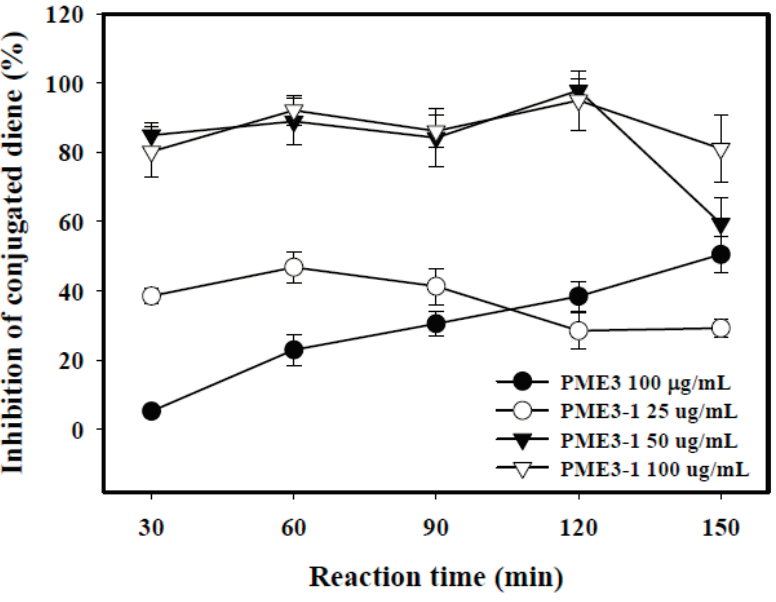
Figure 4. Inhibitory effects of the Pinus morrisonicola extract fraction 3 (PME3) and PME3-1 on conjugated diene levels in cell free n-LDL oxidized by Cu 2+ . Native LDL (n-LDL, 100 μ g/mL) was pre-incubated with PME3 (100 μ g/mL) or increasing concentration of PME3-1 (25–100 μ g/mL) for 1 h. Conjugated diene was induced by the addition of CuSO 4 (10 μ M) at 37 °C for 150